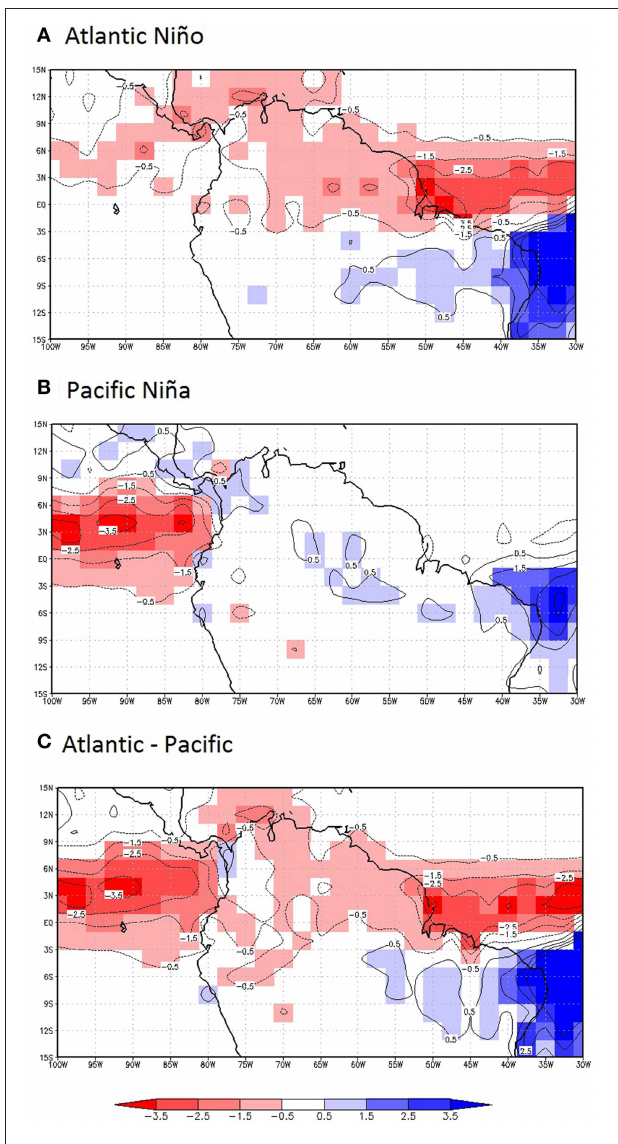
FIGURE 5 | (A) Rainfall anomalies for the Atlantic Niño simulation. (B) Rainfall anomalies for the Pacific Niño simulation. (C) Rainfall anomalies for the simulation in whole Tropical region (Atlantic Pacific). Contoured areas represent the values of the rainfall, expressed in mm/day, while the regions with correlations significant at the 95% level are